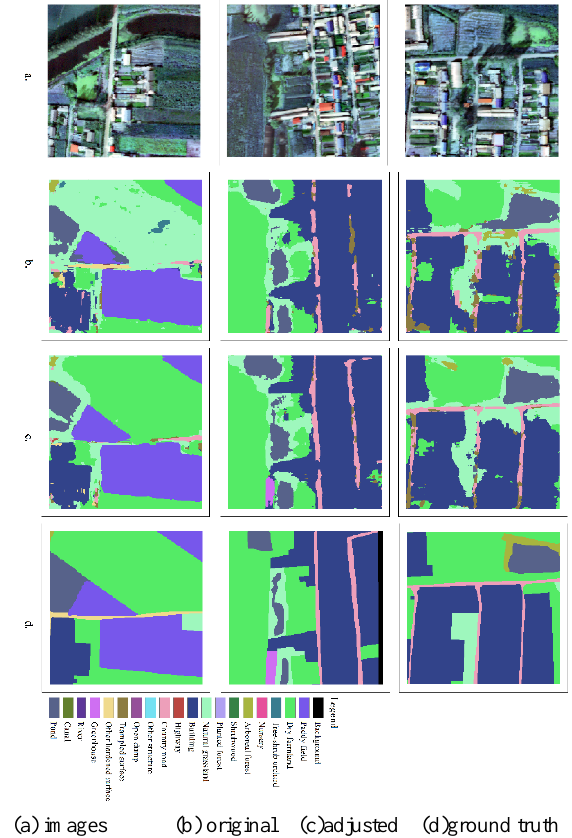
Figure 6 Comparison of extraction results before and